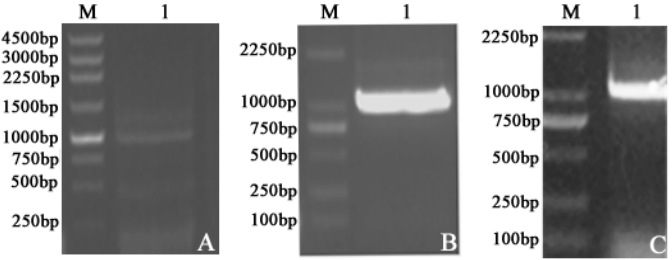
Figure 1. Amplification of plateau pika Ldh-a, Ldh-b and Ldh-c. Lane 1: PCR products of ( A ) Ldh-a ; ( B ) Ldh-b ; and ( C ) Ldh-c. M: DNA marker. The PCR fragments of Ldh-a , Ldh-b , and Ldh-c were 999 bp, 1005 bp and 999 bp. The sequence of transcripts was identical to that in the GenBank for Ldh-a , Ldh-b , and Ldh-c , suggesting that the expression plasmids pCold-SUMO -Ldh-a , pET-30a- Ldh-b , and pET-30a- Ldh-c encoding the full-length pika LDHA, LDHB and LDHC, respectively, were successfully constructed.